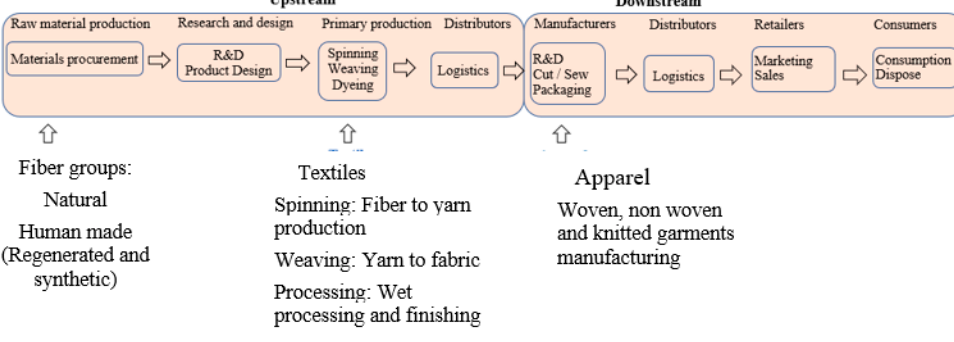
Figure 1. Value chain structure of the fashion industry.